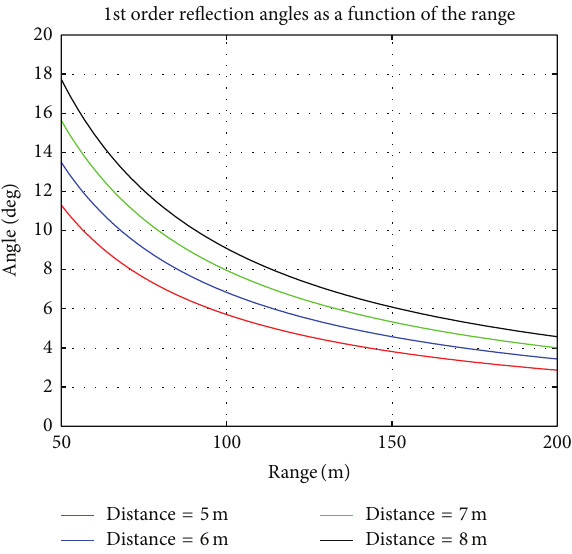
Figure 3: Reflection angles ( 𝛼 𝑖 ) for different obstacles distances as a function of the range.